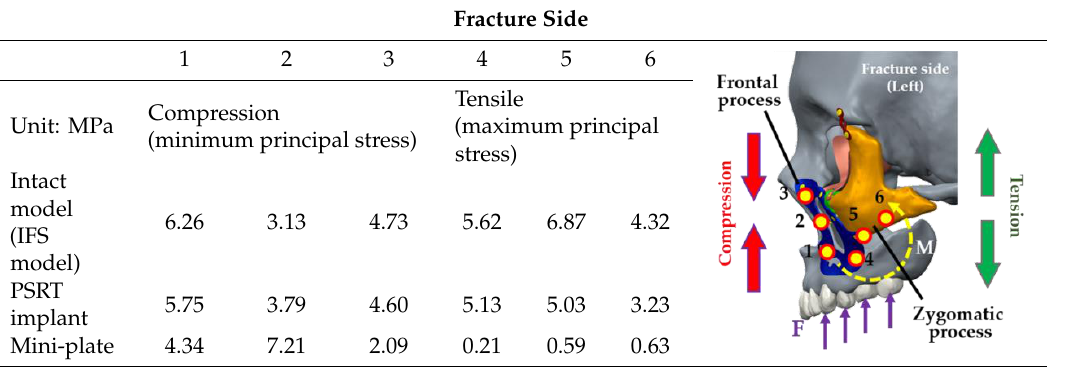
Table 2. Stress values of the bone corresponding to the points 1 to 6 positions.